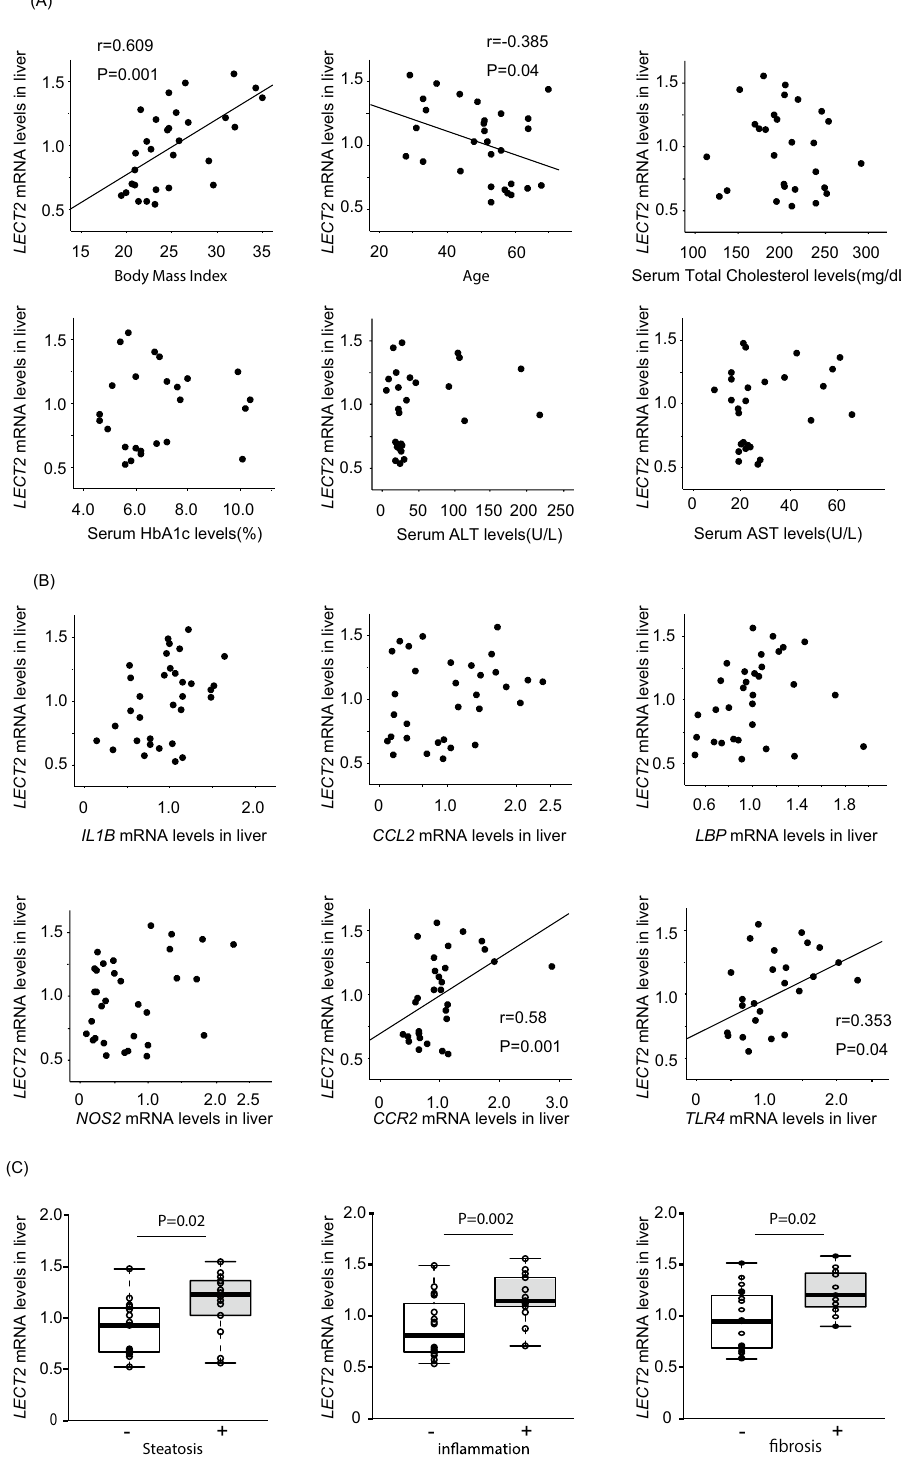
Figure 1. Hepatic LECT2 gene expression level correlates with liver steatosis and gene expression levels of inflammation-related genes in the liver. ( A ) Correlations between LECT2 gene expression in the liver and BMI, age, T-Chol, FPG, HbA1c, ALT, AST in humans (n = 32). ( B ) Correlations between LECT2 gene expression in the liver and IL-1b , CCL2 , LBP , NOS2 , CCR2 , TLR4 in humans (n = 32). ( C ) Correlations between LECT2 gene expression in the liver and Pathological inflammation and steatosis in humans (n = 32). *P <